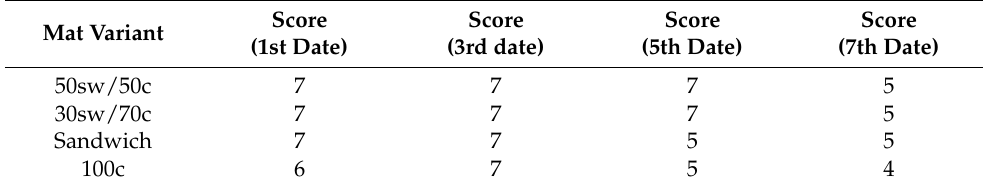
Table 5. Medians of the awarded scores of all perennials on the different vegetation mats on the 1st, 3rd, 5th, and 7th assessment